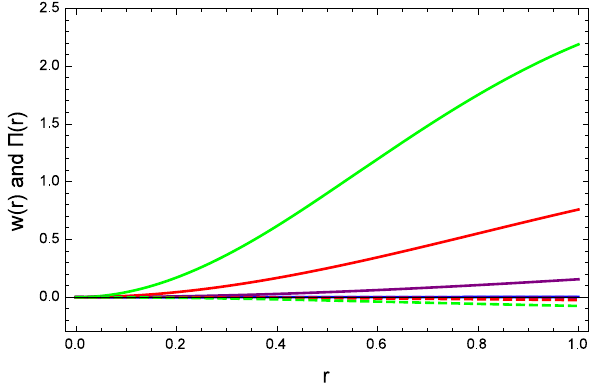
Fig. 4 w( r ) (solid lines) and Π( r ) (dashed lines) vs the radial coor- dinate r for fixed α = 0 and K = − 2 (Blue), K = − 20 (Purple), K = − 50 (Red), K = − 100